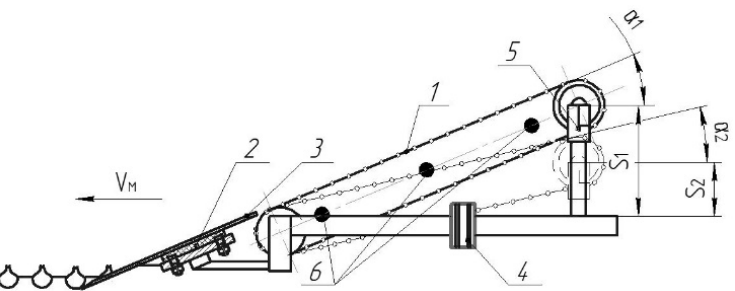
Figure 3. Scheme for changing the angle of inclination of the bar elevator conveyor: 1—bar elevator; 2—weight sensor of the digging share; 3—digging share; 4—microcontroller; 5—electric cylinder; and 6—inertial sensor; ← - forward movement